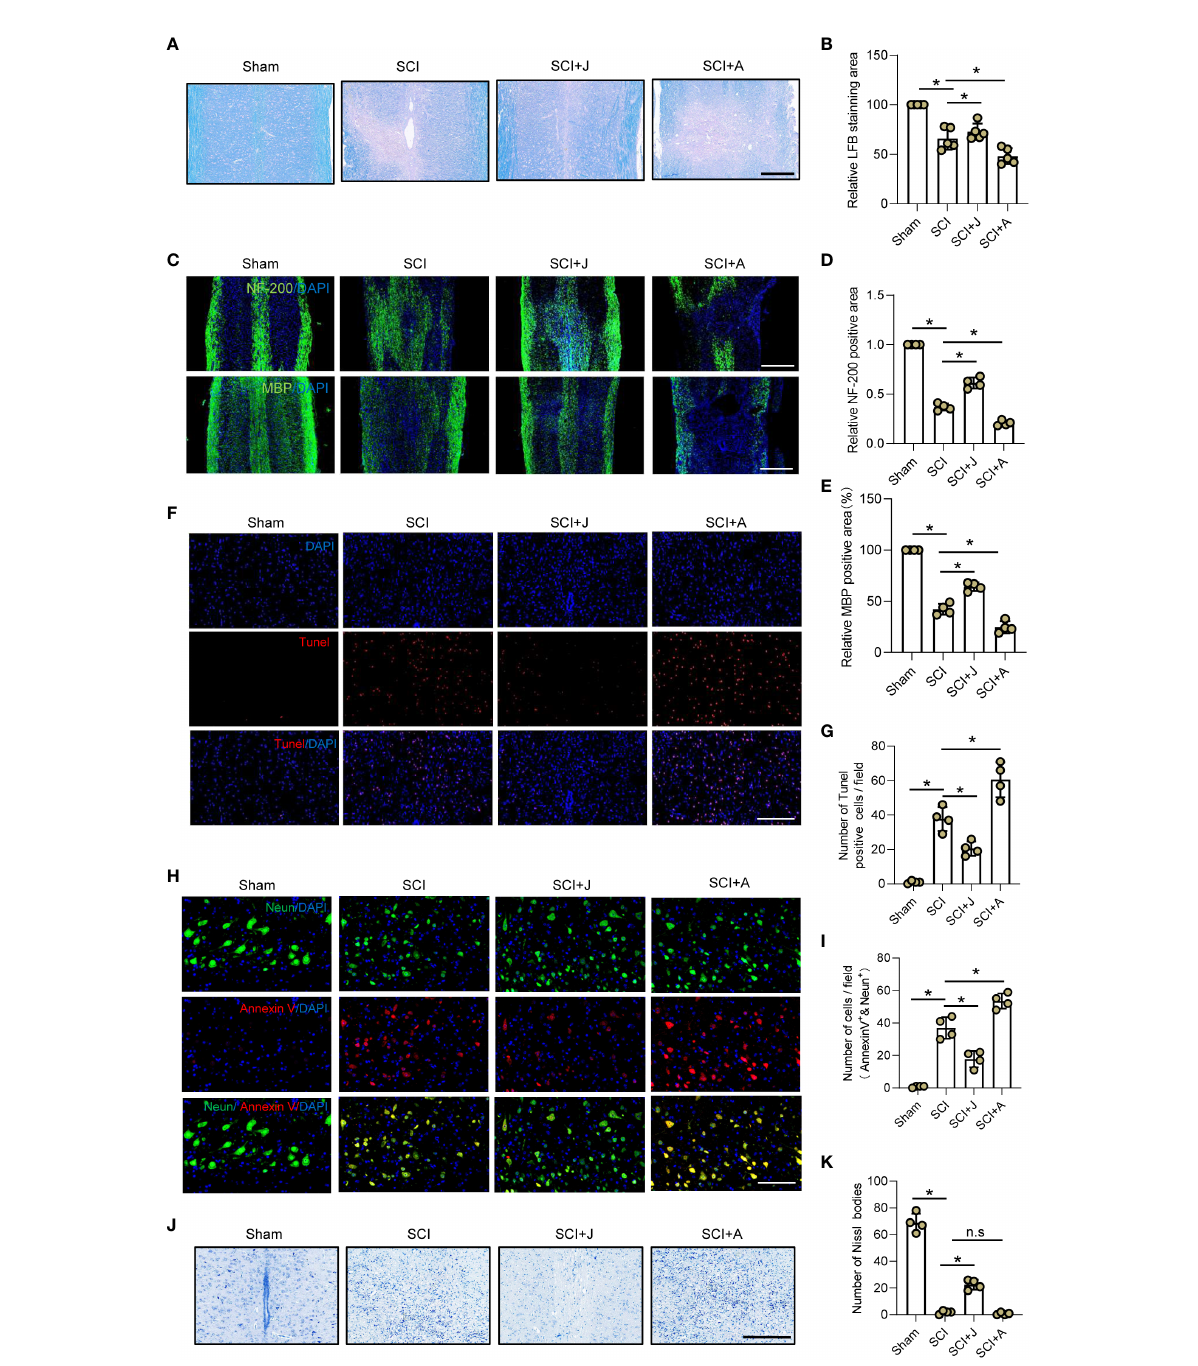
FIGURE 5 CB2R ameliorated secondary neuronal apoptosis and demyelination post-SCI. (A) LFB staining of spinal cords on day 7 post-SCI. Scale bar = 200 m m. (B) Quantitative analysis of LFB-labeled area. (C) IF staining of NF200 or myelin basic protein (green) on day 7 post-SCI. Scale bar = 500 m m. (D) Quantitative analysis of NF200. (E) Quantitative analysis of myelin basic protein. (F) TUNEL staining of spinal cords on day 7 post- SCI. Scale bar = 100 m m. (G) Quantitative analysis of TUNEL-positive cells. (H) IF staining of Neun (green) and Annexin V (red) on day 7 post-SCI. Scale bar = 100 m m. (I) Quantitative analysis of Annexin V-positive neurons. (J) Nissl staining of spinal cords on day 7 post-SCI. Scale bar = 200 m m. (K) Quantitative analysis of the number of neurons. * p < 0.05. n.s means no signi fi